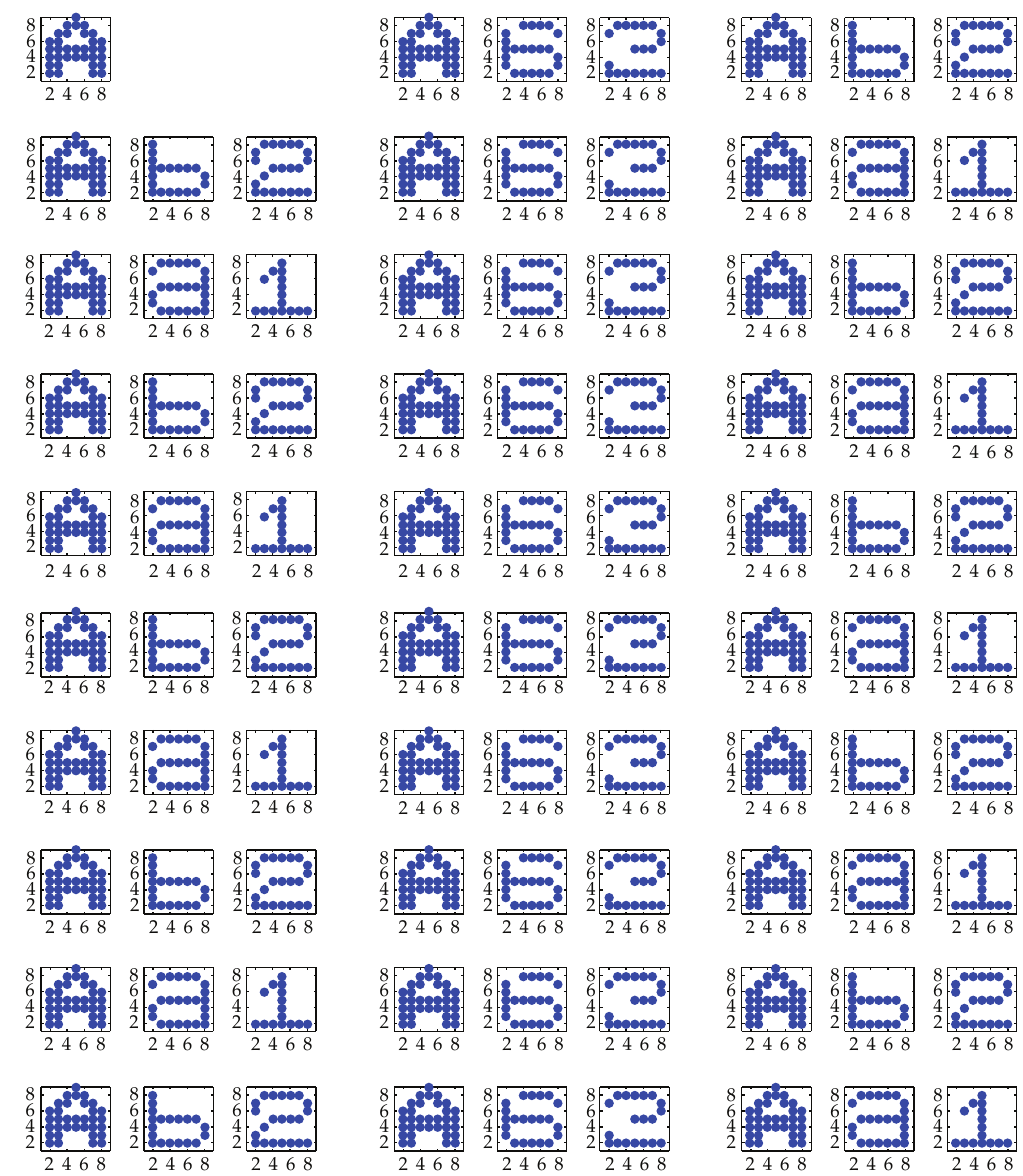
Figure 12: Output of the proposed MCNN for many-to-many associative